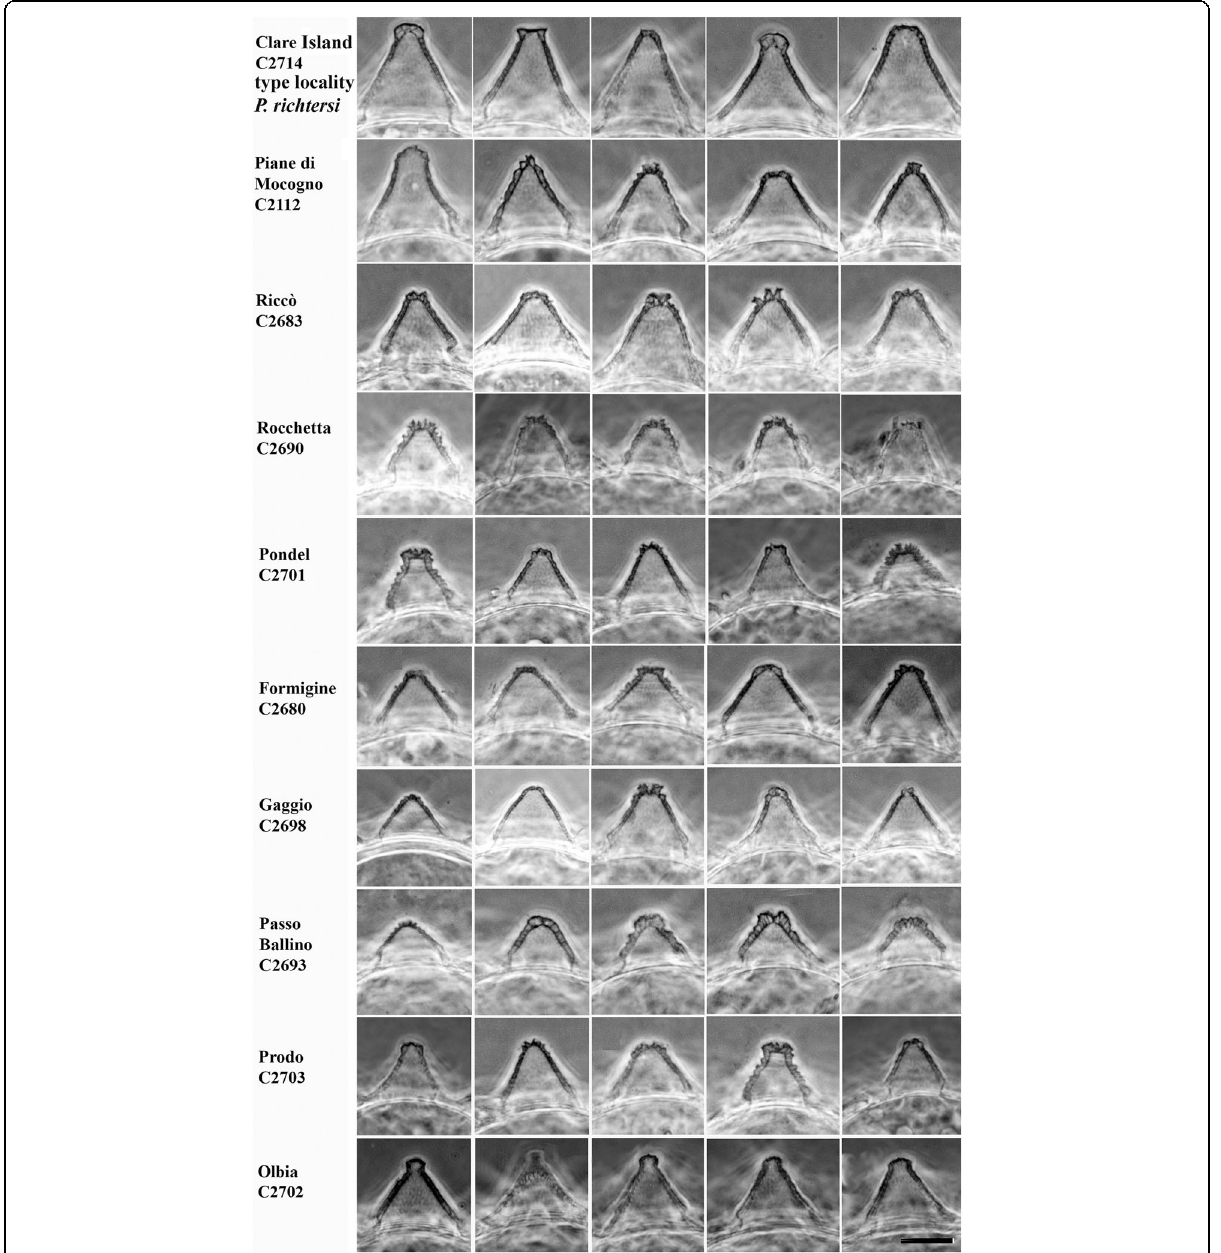
Fig. 5 Variability of the egg process morphologies among and within the eggs of the studied populations (PhC). Bar = 10 μ m (for all